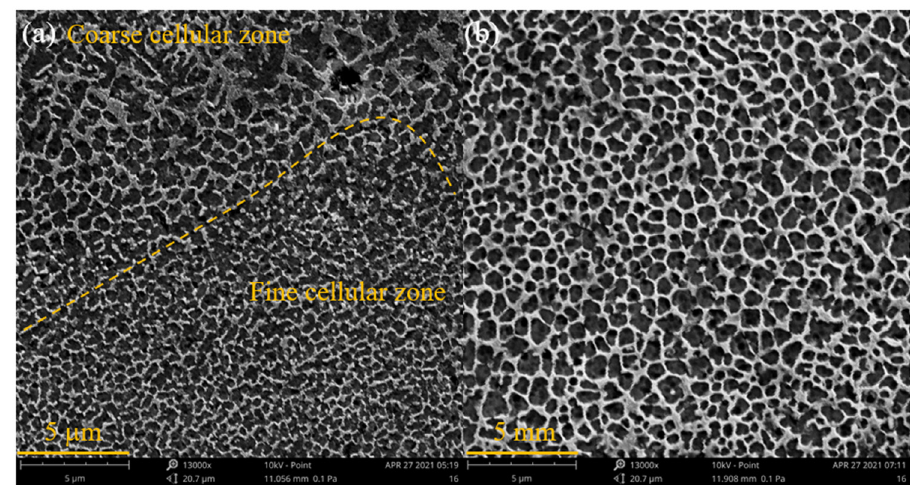
Figure 2: The subgrain textures of CNTs/AlSi10Mg nanocomposites exhibit a eutectic and subcellular Al – Si microstructure in a plane perpendicular to the build direction for ( a ) sample no. 1 with a laser power of 450 W and a laser scan speed of 2.4 m/s showing fi ne and coarse cellular microstructure, and ( b ) sample no. 15 with a laser power of 350 W and a laser scan speed of 2.0 m/s showing a nonuniform fi ne cell